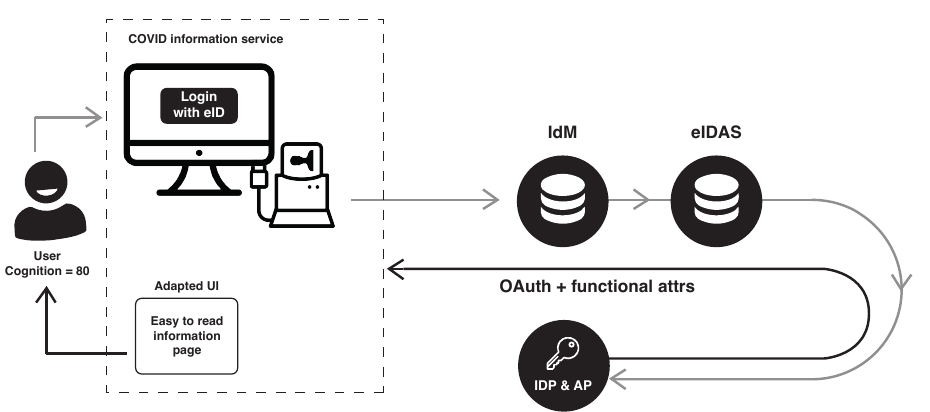
Figure 6. Demo e-service diagram.